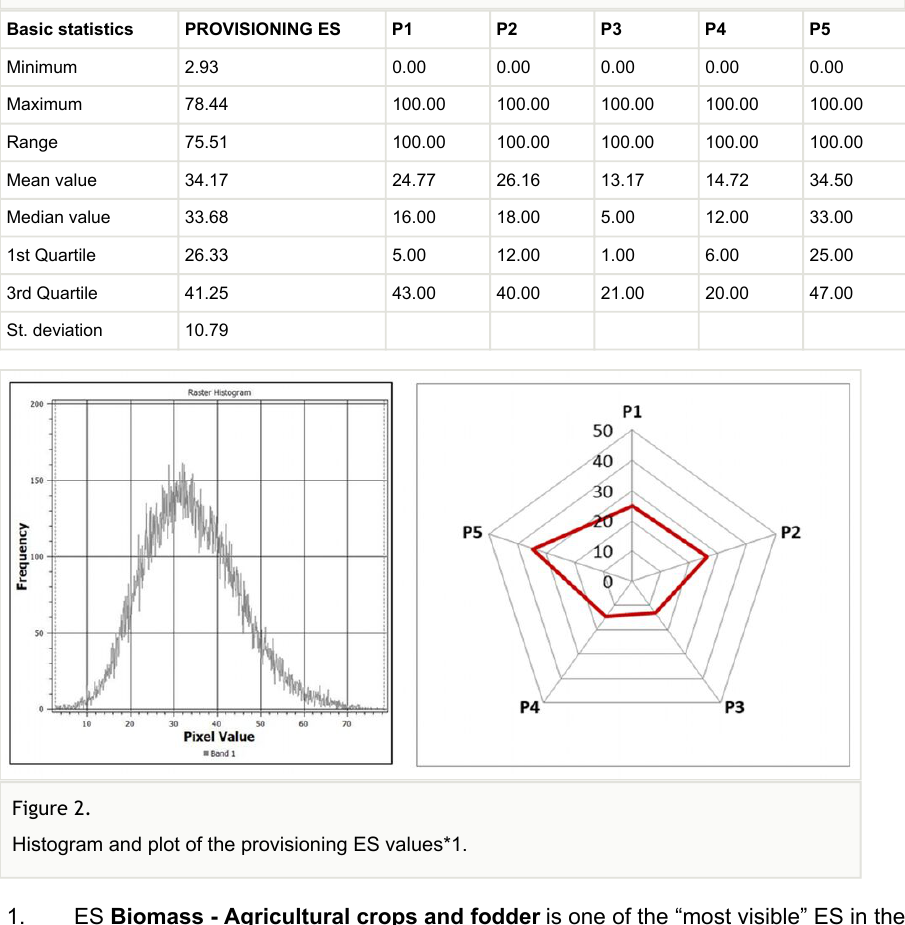
Table 3. Basic statistical parameters of the provisioning ES*1.